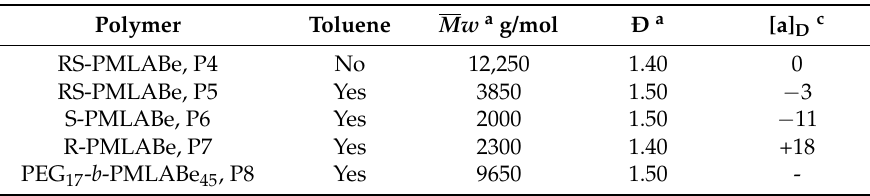
Table 3. Characteristics of RS-PMLABe (P4 and P5), S-PMLABe (P6), R-PMLABe (P7), and PEG 17 -b-PMLABe 45 (P8) obtained by enzymatic polymerization in presence of porcine pancreatic lipase (PPL) as the catalyst.